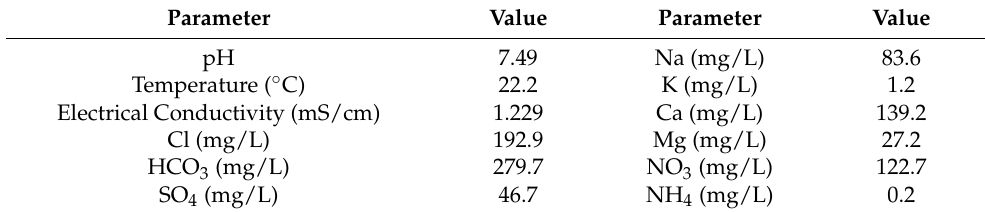
Table 4. Main physicochemical characteristics of the irrigation